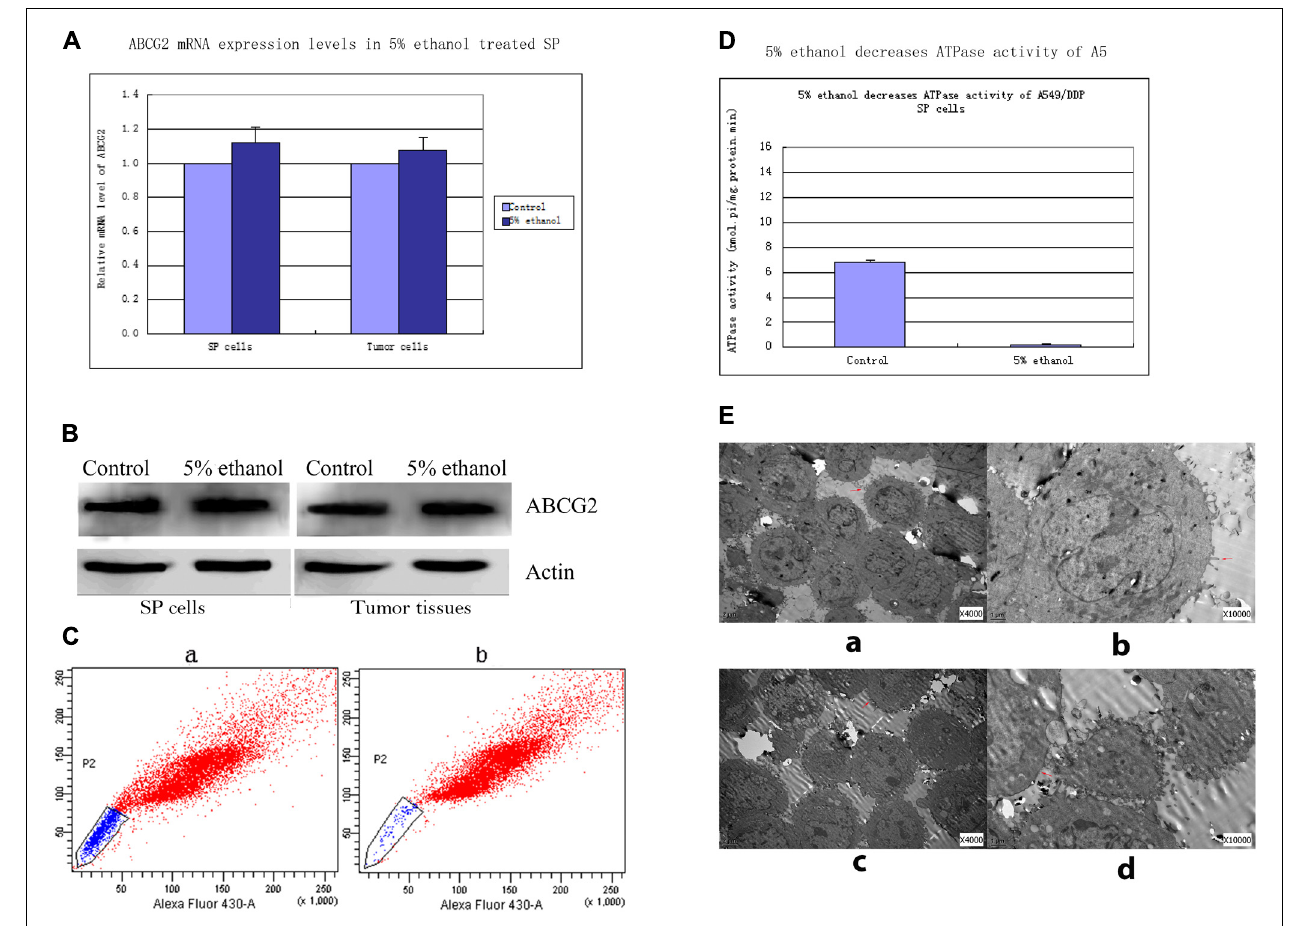
ethanol-treated SP cells. (E) Surface morphology of SP cells treated with 5% ethanol and control byTEM. (a) TEM image of control SP cells ( × 4000). (b) TEM image of control SP cells ( × 10000). (c) TEM image of 5% ethanol-treated SP cells ( × 4000). Notable shortened microvilli and diminution in their number were showed.The shortened microvilli are indicated by arrows. (d) TEM image of 5% ethanol-treated SP cells ( ×